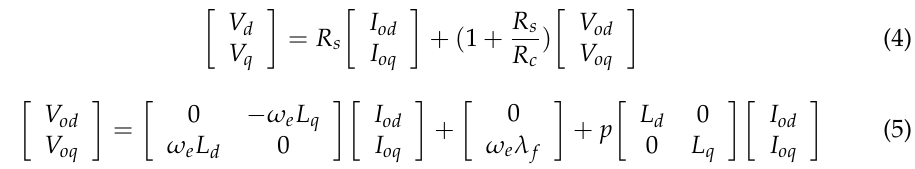
Figure 9. ECM of PMSMs with predictable core loss: ( a ) d -axis; ( b ) q -axis.